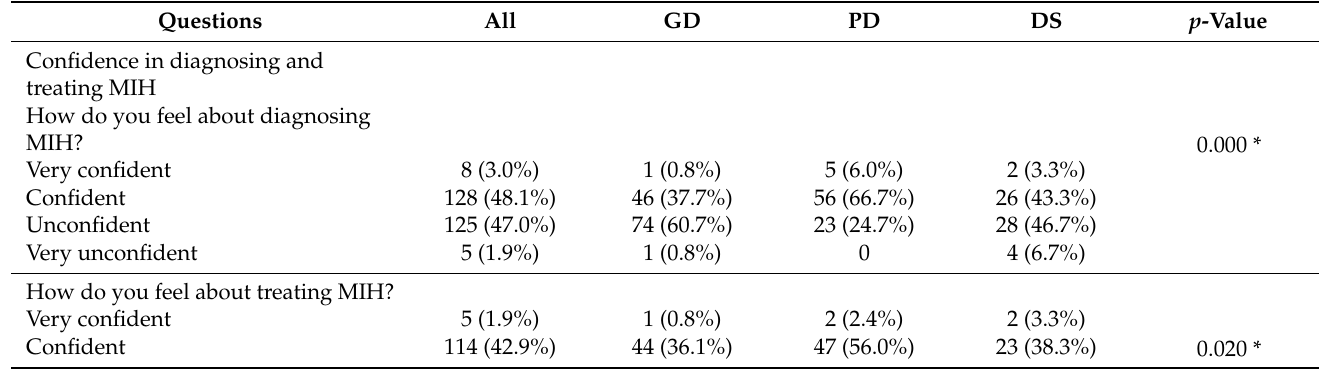
Table 3. Confidence and continuing education aspects regarding MIH among general